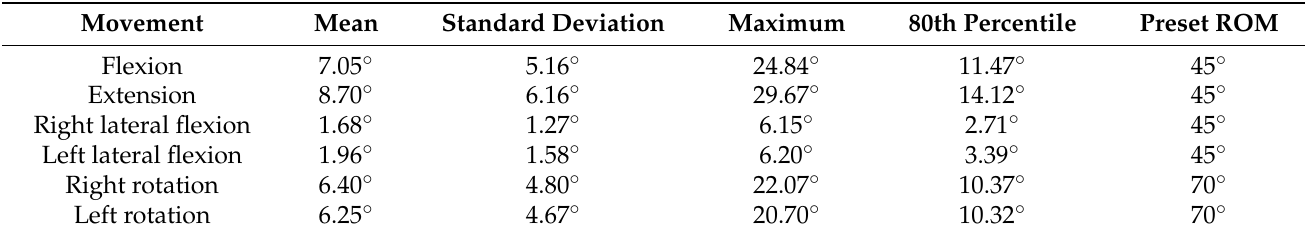
Table 6. ROM results of Profile 4 (After outliers’ filtering, the analyzed data for the Profile 4 supposed a 99% of the total flexion-extension raw data, a 96% of the total lateral flexion raw data, and a 98% of the total rotation raw data). Movement Mean Standard Deviation Maximum 80th Percentile Flexion